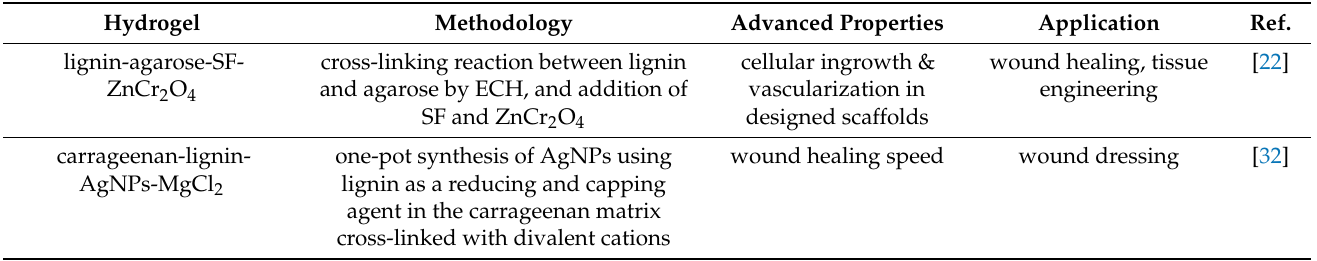
Table 1. Literature overview of lignin-based hydrogels and their